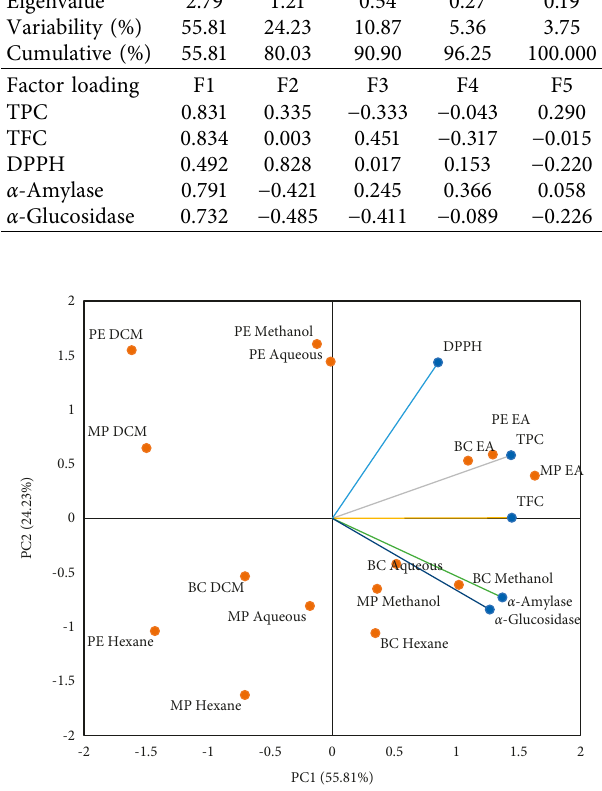
Figure 3: Factor score of 15 fractions of 3 medicinal plants in PC1 ( x ) and PC2 ( y